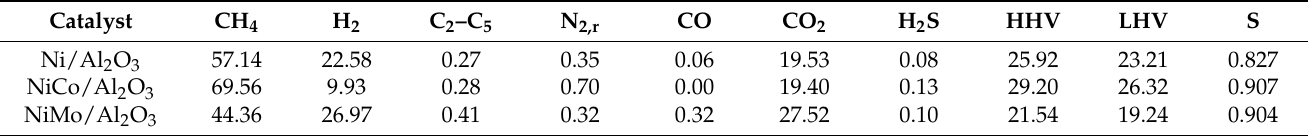
Table 5. Composition of the resulting gas from catalyzed pressure pyrolysis of birch shavings (vol.%). HHV—higher heating value, LHV—lower heating value (both MJ/kg), S—gas density (kg/m 3 ). Catalyst CH